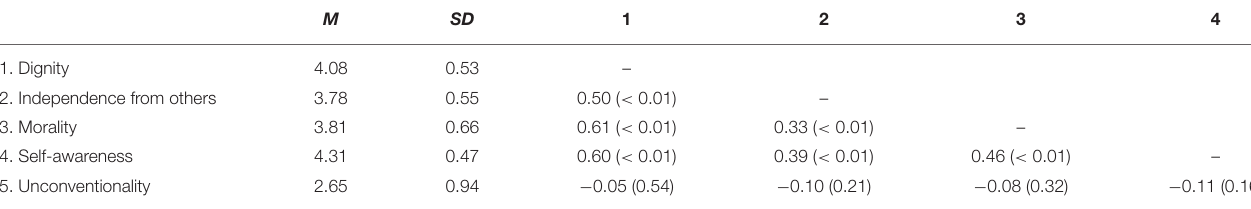
TABLE 2 | Descriptive statistics and Spearman’s rank inter-correlations r S ( p -value) for the five autonomy components. M SD 1 2 3